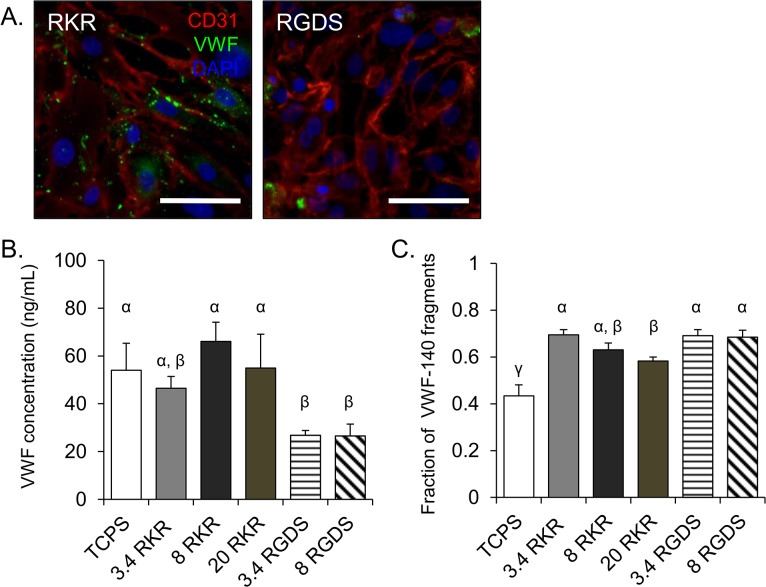
VECs produce, release, and actively cleave von Willebrand factor.(A) Non-stimulated VECs seeded on hydrogels (3.4 kDa) functionalized with RKR (left) or RGDS (right) stained for CD31 (red) and VWF (green). Nucleus was stained with DAPI (blue). Scale bar = 50 μm. (B) Quantification of rapidly released VWF and (C) the fraction of cleaved VWF-140 fragments from histamine-stimulated VECs cultured on different molecular weight hydrogels functionalized with RKR or RGDS, or TCPS. Groups not connected by same symbols are significantly different. p < 0.05.